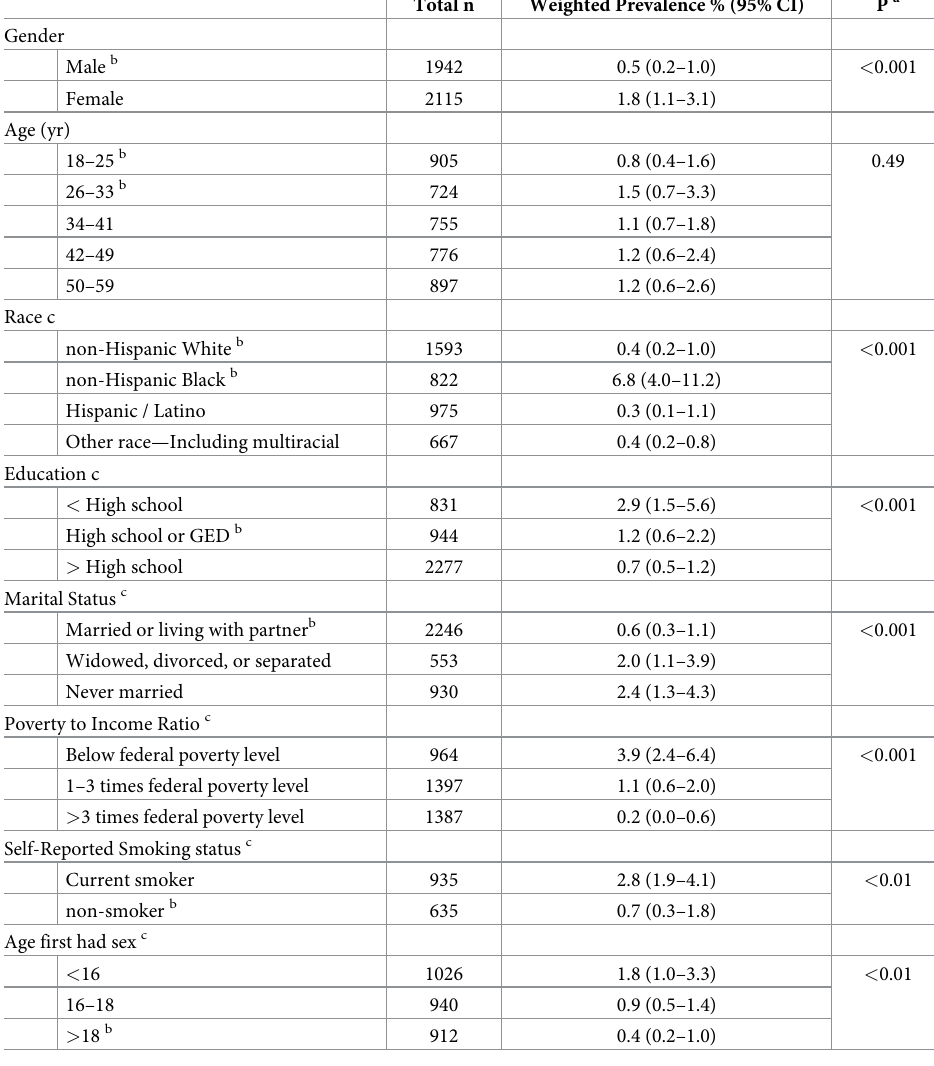
Table 1. Prevalence of T . vaginalis infection by participant characteristics, n = 4057.